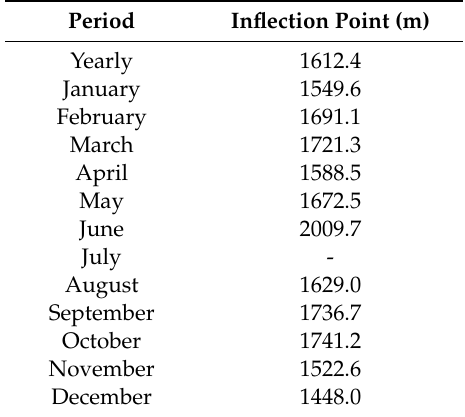
Table 2. Inflection points of the adjusted quadratic trend for the di ff erent months.